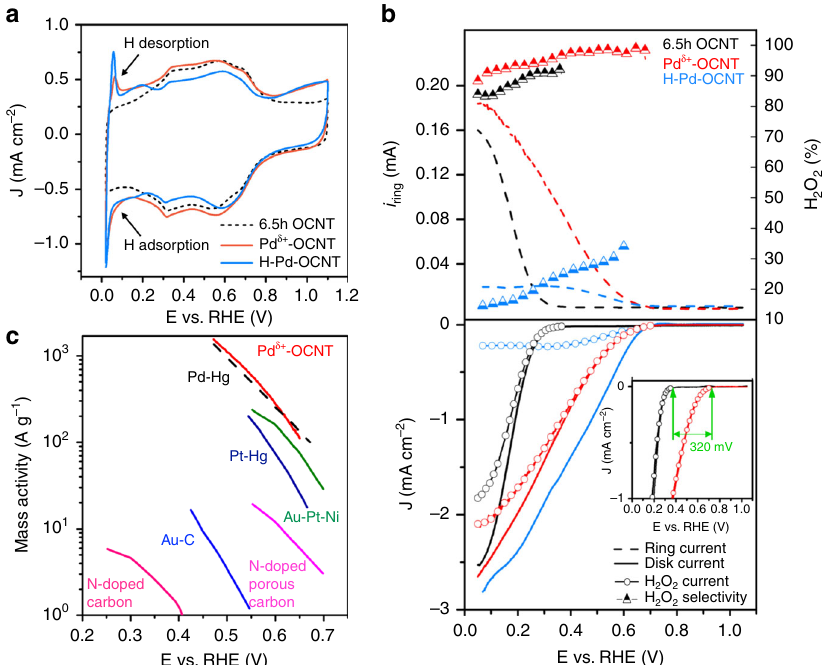
Fig. 3 Electrochemical performance of Pd δ + -OCNT and H-Pd-OCNT catalysts. a CV curves of different electrocatalysts showing distinct H adsorption/ desorption characteristics at a scan rate of 50 mV s − 1 . The electrolyte was Ar-saturated 0.1 M HClO 4 solution. b RRDE voltammograms in O 2 -saturated HClO 4 electrolyte with a scan rate of 10 mV s − 1 at 1600 rpm (only the anodic cycle is shown). The H 2 O 2 current and selectivity were calculated from the ring and disc currents for both OCNT and Pd δ + -OCNT. c Mass activity of the state-of-the-art electrocatalysts for H 2 O 2 production in the acid electrolyte. Data were taken from previous reports 8, 9, 15, 20, 24, 35, 36 OCNT ( I D /I G = 1.88). Also, the basal plane sp 2 carbon oxidization